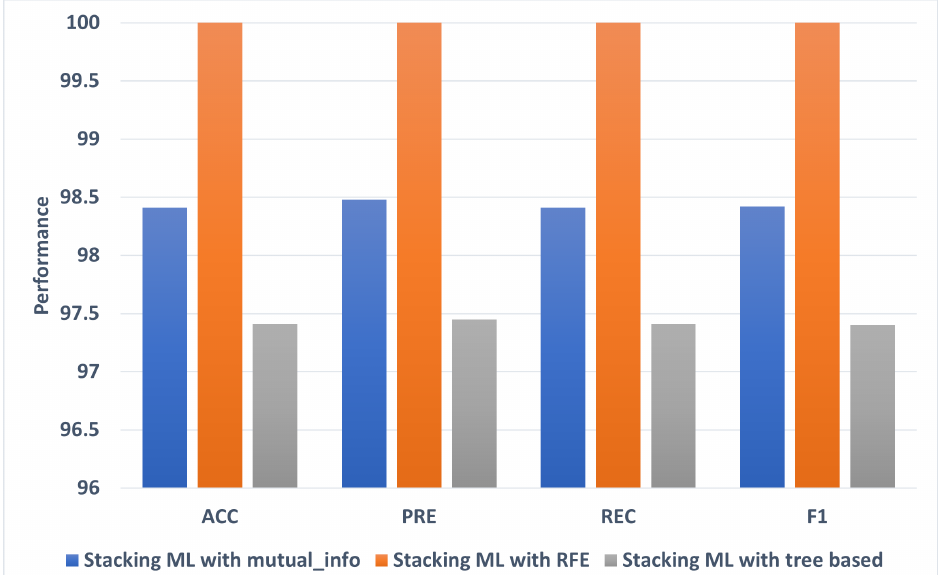
Figure 8. The best models for 80:20 splitting.